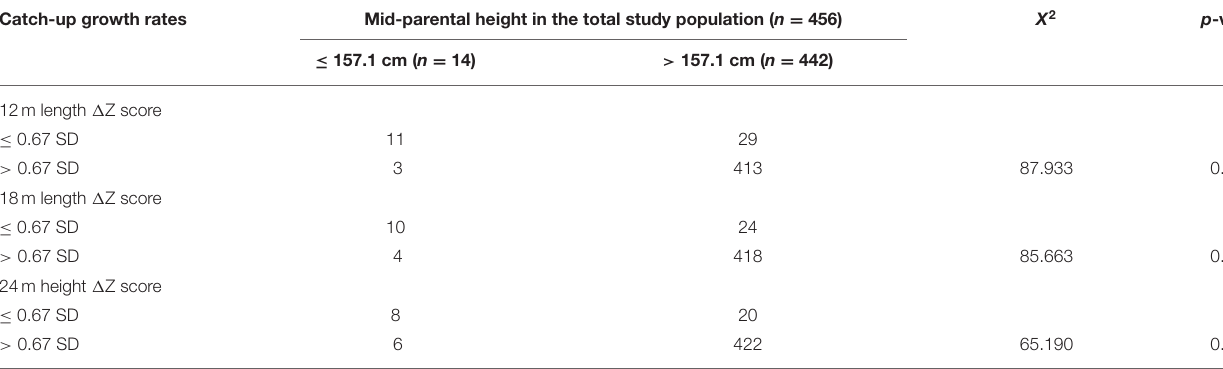
TABLE 4 | The chi squared test of catch-up growth vs. the classification of parental short stature. Catch-up growth